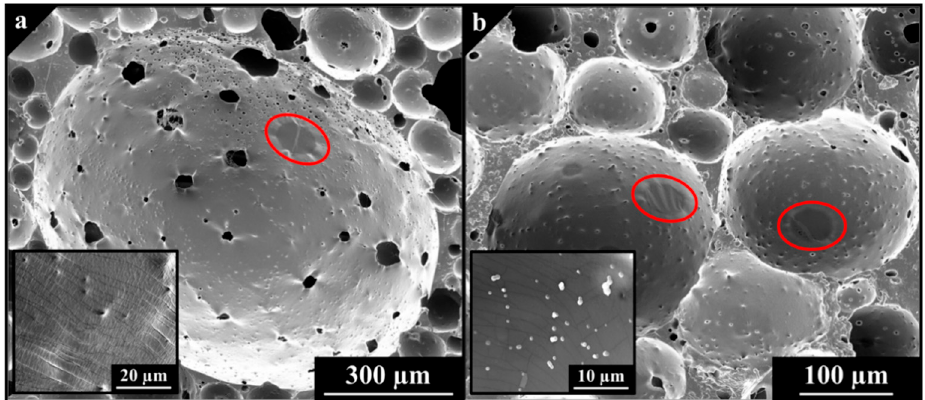
Figure 3. Electron microscope images highlighting the mechanisms leading to the partial perforation in ( a ) EML227 and ( b ) EML350 polyurea foams and elucidating the cell expansion process during foaming (see insets).